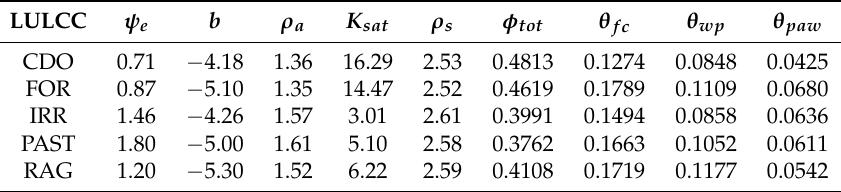
Figure 4. Profile average of soil bulk density standard deviation for different land use and land cover classes. The total samples are 714 distributed in: Cerrado areas (CDO), n = 22; Forest formations (FOR), n = 19; Irrigated agriculture (IRR), n= 20; Pasture (PAST), n = 21; and Rainfed agriculture areas (RAG), n = 20, multiplied by 7 depths. Table 1. Average soil physical parameters for 0–5 cm layer under different land use cover in the Western of Bahia used in this